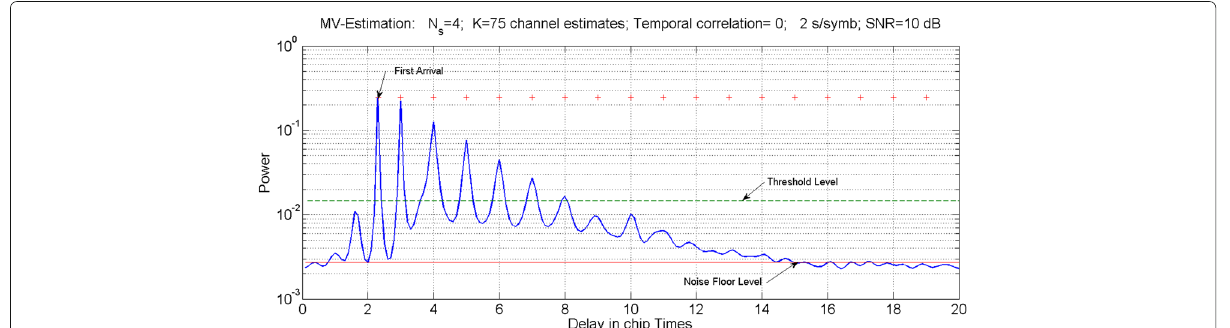
Fig. 12 Minimum variance spectrum for timing estimation. This result is provided for a SNR of 10 dB, an ICD source ( α = 0), 75 channel vector estimates available; the sampling rate set to twice the chip rate, delay spread set to 2 T c , angular spread set to 5°, and four sensors